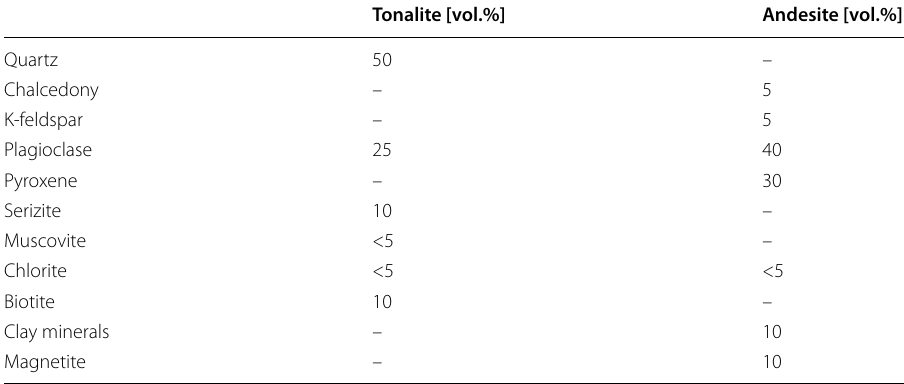
Table 1 Volumetric mineral composition of reservoir rock analogues used for laboratory